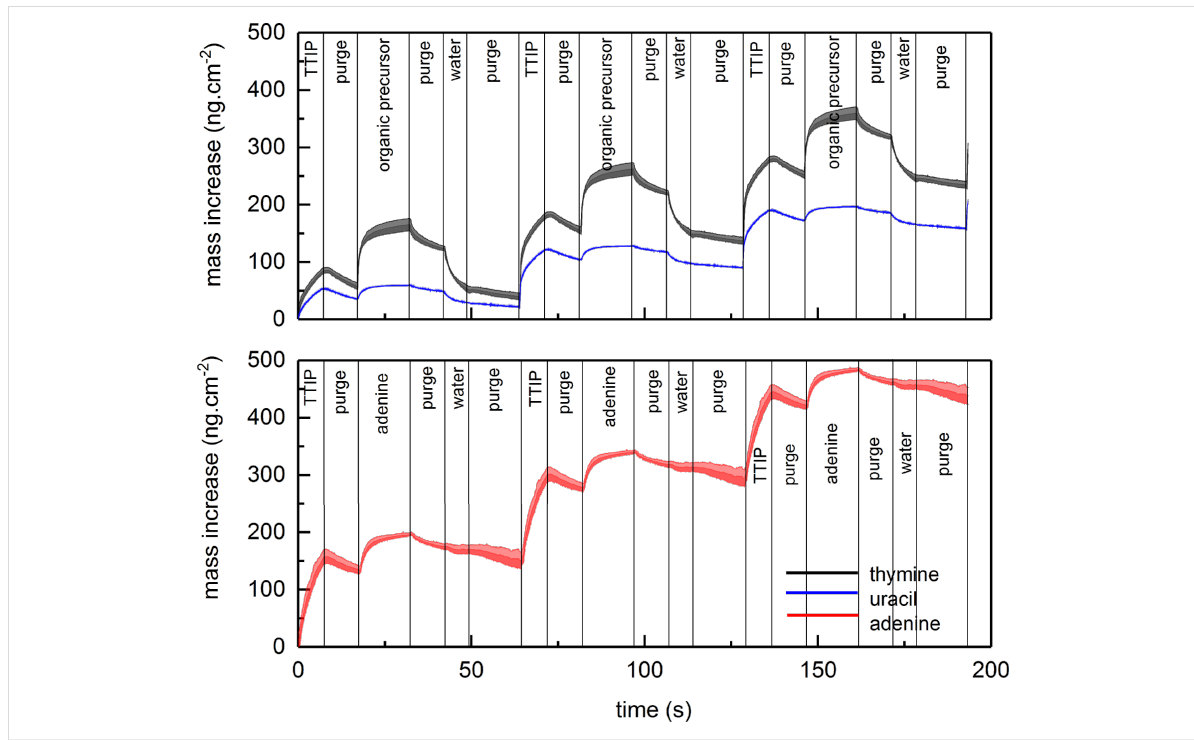
Figure 7: Evaluation of the mass increase during growth measured by QCM using TTIP and thymine (at 225 °C) (top graph), uracil (at 225 °C) (top graph), or adenine (250 °C) (bottom graph), and water. The shaded area represents the statistical variation during 16 cycles.